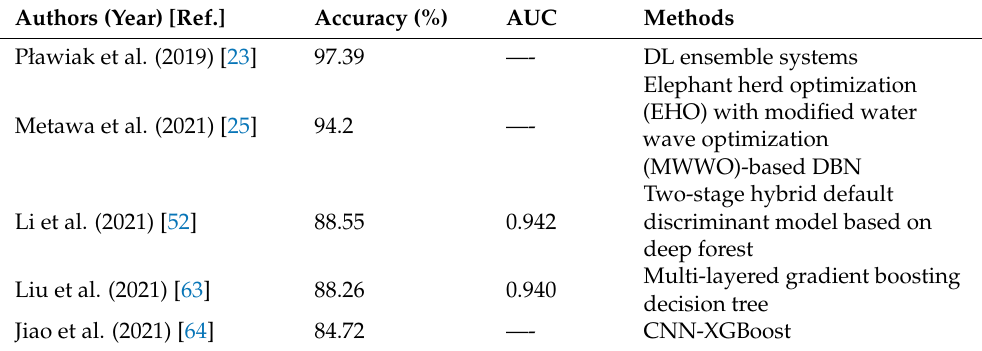
Table 7. Accuracy and area under the receiver operating characteristic curve (AUC) values of deep-learning-based classifiers for the Australian dataset.